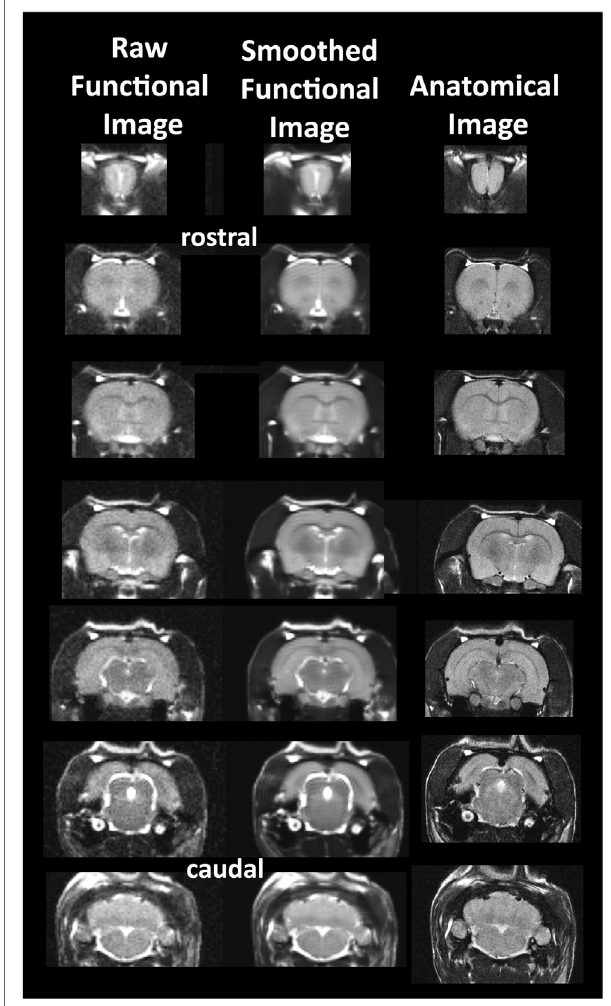
FigUre 1 | neuroanatomical fidelity . Shown are representative examples of brain images collected during a single imaging session using a multi-slice spin echo, RARE (rapid acquisition with relaxation enhancement) pulse sequence. The column on the right shows axial sections collected during the anatomical scan taken at the beginning of each imaging session using a data matrix of 256 × 256, 22 slices in a field of view of 3.0 cm. The column on the left shows the same images but collected for functional analysis using HASTE, a RARE pulse sequence modified for faster acquisition time. These images were acquired using the same field of view and slice anatomy but a larger data matrix of 96 × 96. The images in the middle column have been smoothed during pre-processing. Note the anatomical fidelity between the functional images and their original anatomical image. The absence of any distortion is necessary when registering the data to atlas to resolve 171 segmented brain